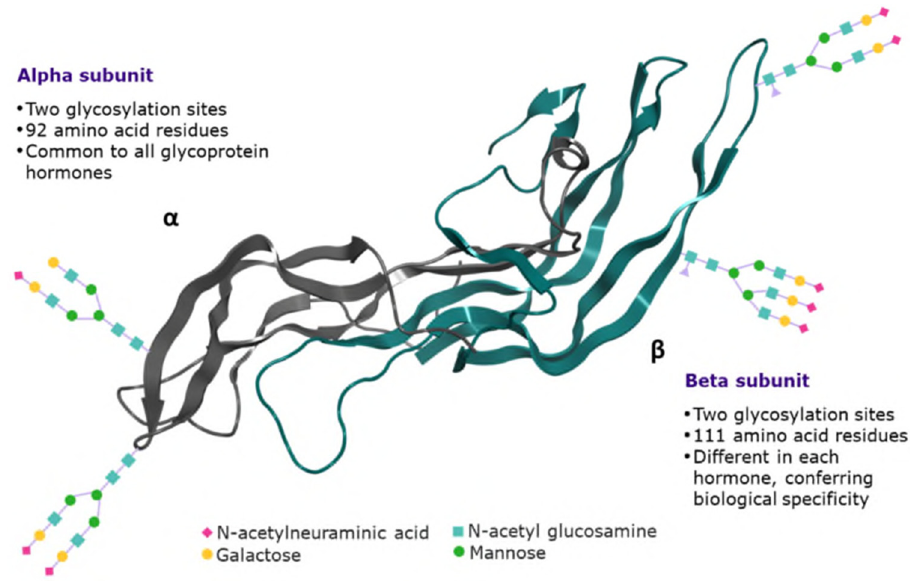
Figure 1. Graphical representation of human follicle-stimulating hormone. Table 1. Batches tested per